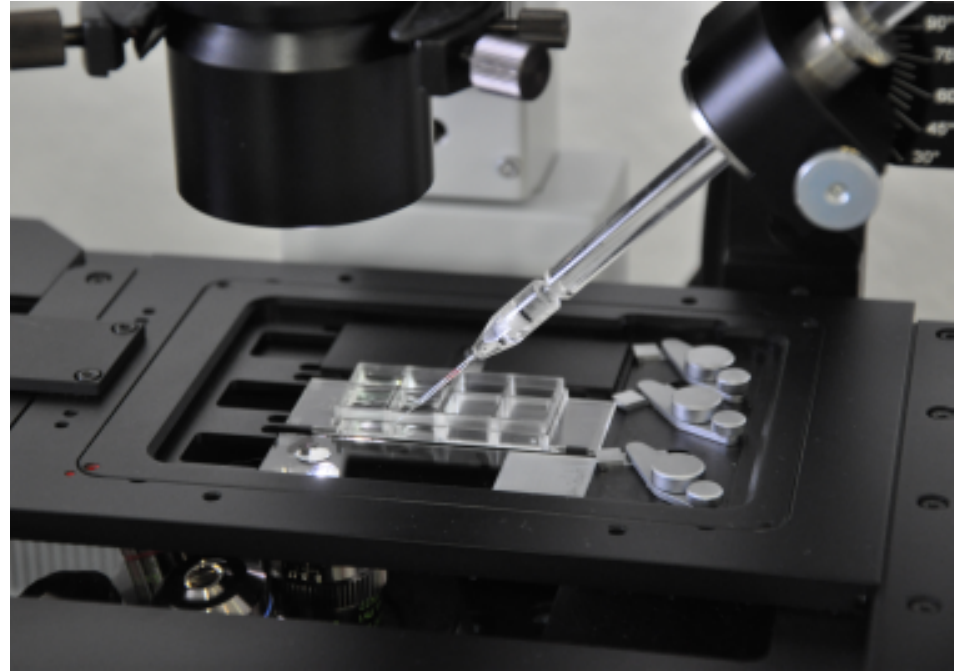
Figure 2. High-performance stereomicroscope and preparation platform MMI CellEctor plus™ with a three-dimensionally-controllable micromanipulator.